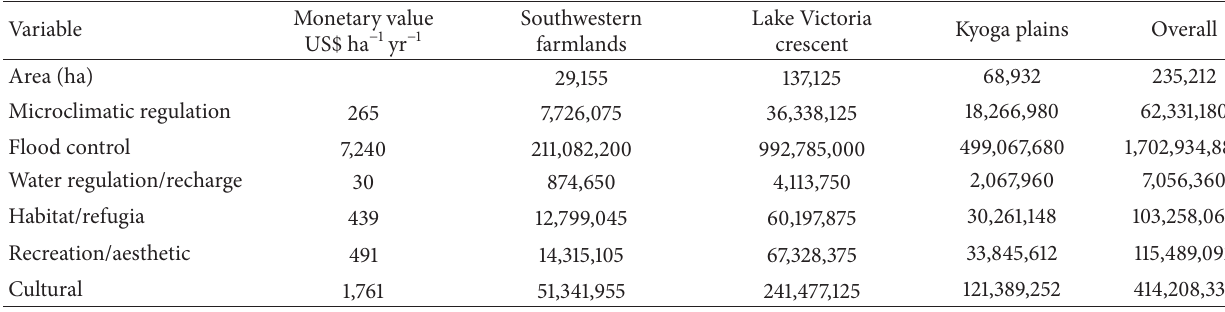
Table 12: Monetary contribution of wetland non-use values in three agro-ecological zones of Uganda.